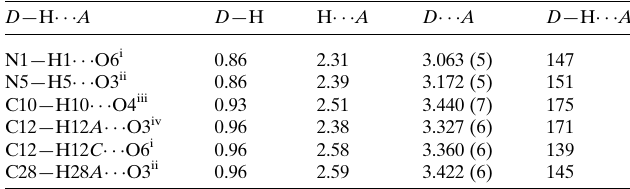
Table 1 Hydrogen-bond geometry (A˚ , (cid:2) ).